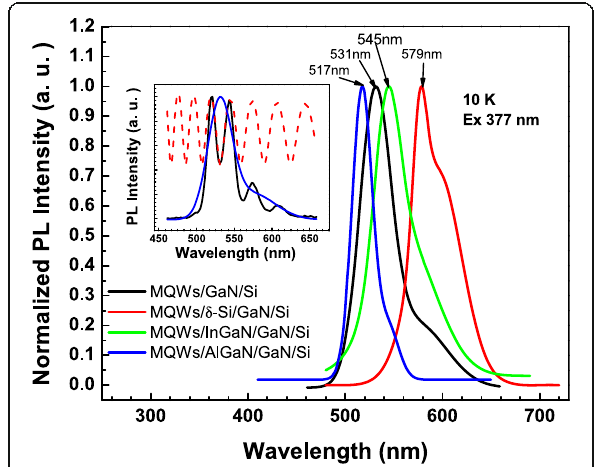
Fig. 2 Overview of SSPL for S1 – S4 excited by 377 nm laser at 10 K. The original PL signals contain Fabry-Perot oscillation which is shown as the black curve in the insert (S1 as an example). The oscillation item (red dash curve) and Gaussian PL peak (blue curve) are split by fitting the original signals. All PL data for S1 – S4 are treated by the same method, and then, the split Gaussian PL are shown in the figure